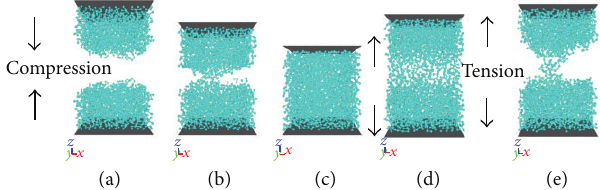
Figure 37: The simulated nanomechanics for nonfunctional PFPE ( 𝜀 𝑝 𝑏 = 𝜀 𝑝 𝑤 = 0 ) films: (a) two well-equilibrated films approach each other, so-called “compression”; (b) two films are in contact; (c) two films completely contact and merge into one confined film; (d) the top surface is retracted, so-called “tension”; and (e) the confined film is being separated into two parts in the nearly end of the “tension.”